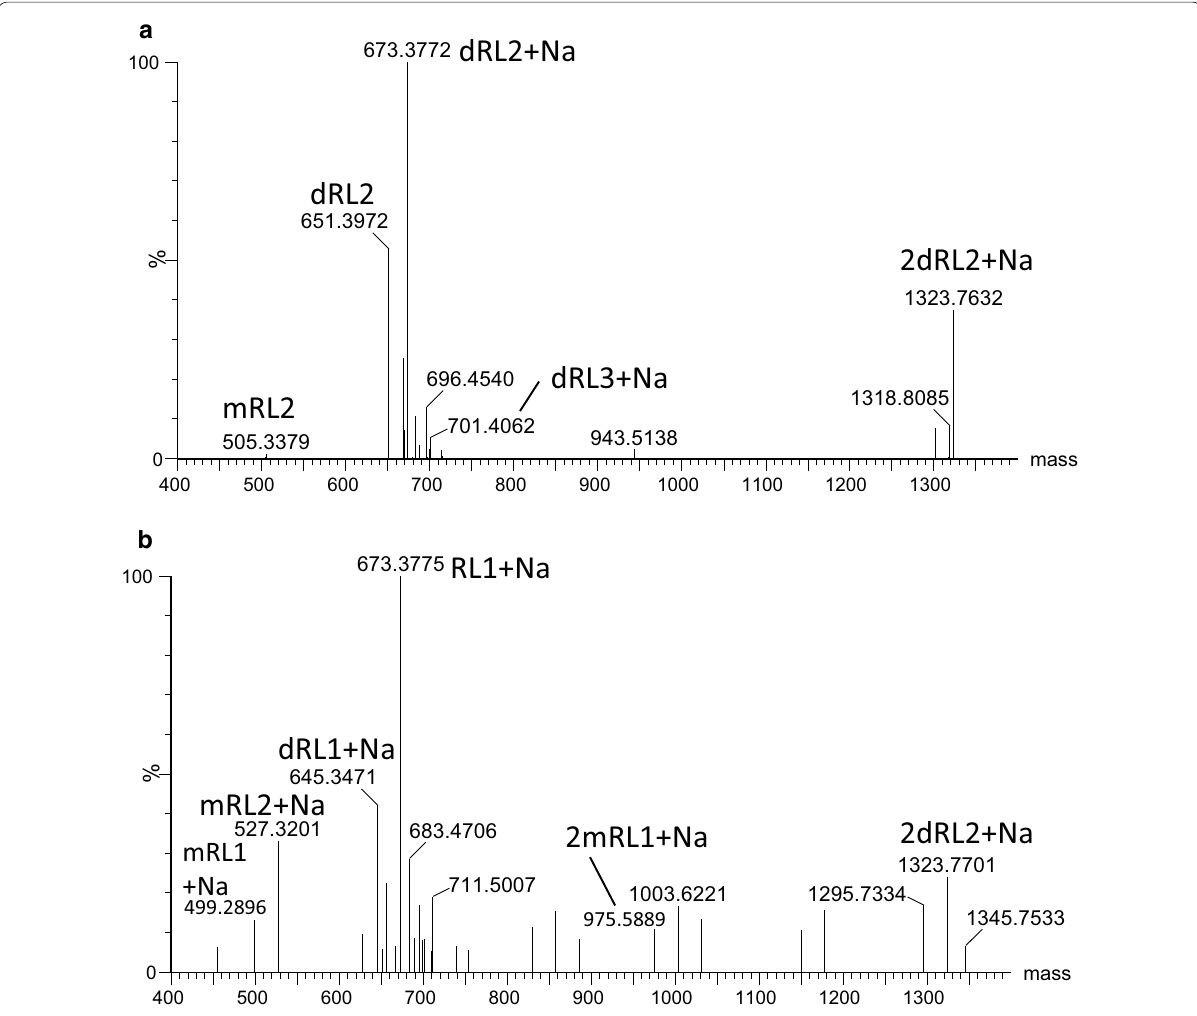
Fig. 4 ESI–MS analysis of the ST5 glycerol-MSM extract ( a ) and rhamnolipid standard ( b ). The positive mass spectrum generated with MaxEnt 3 is shown. The indicated masses are [ M r